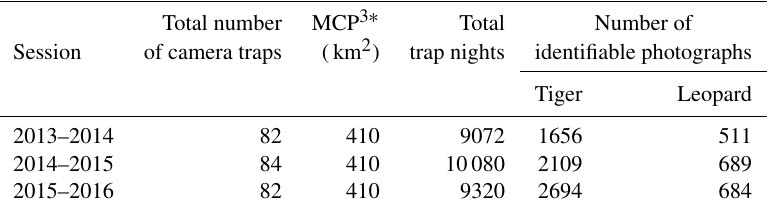
Table A1. Camera trapping efforts in Pench Tiger Reserve, Madhya Pradesh, during 2013–2016, (* MCP: minimum convex